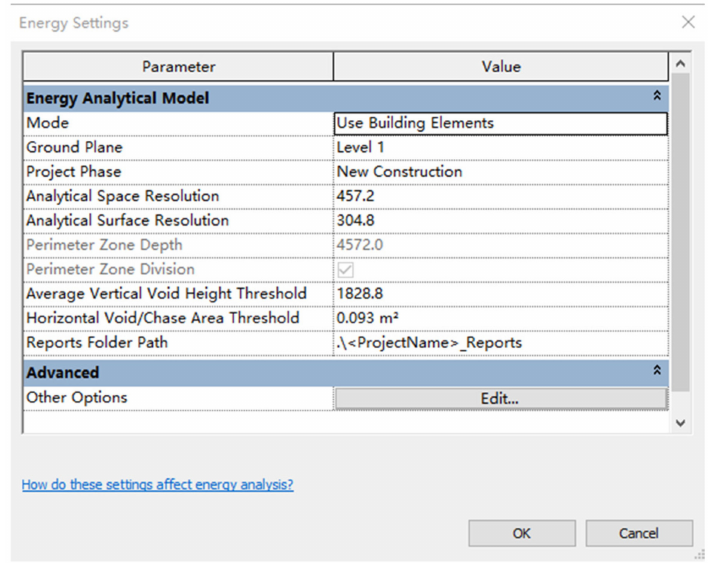
Figure A6. Case Study—Energy setting in BIM.